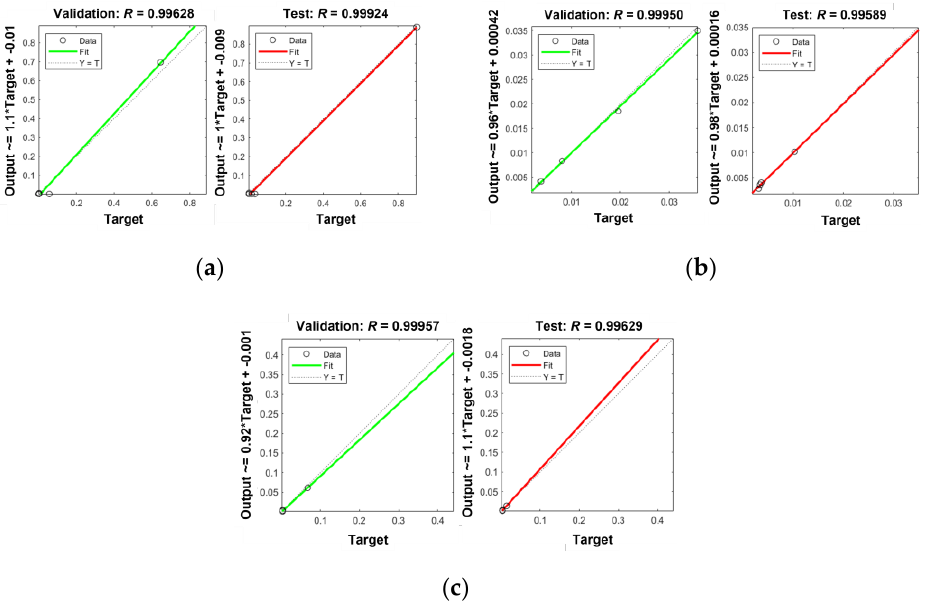
Figure A11. Correlation plots for NN-PSO simulations of TCR (adults) for ( a ) TW, ( b ) GW, and ( c ) WRS.